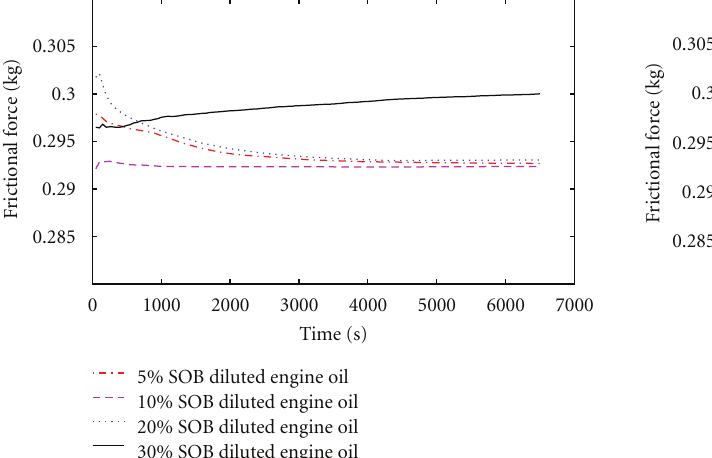
Figure 9: Friction force versus time for chicken fat-oil biodiesel diluted engine oil